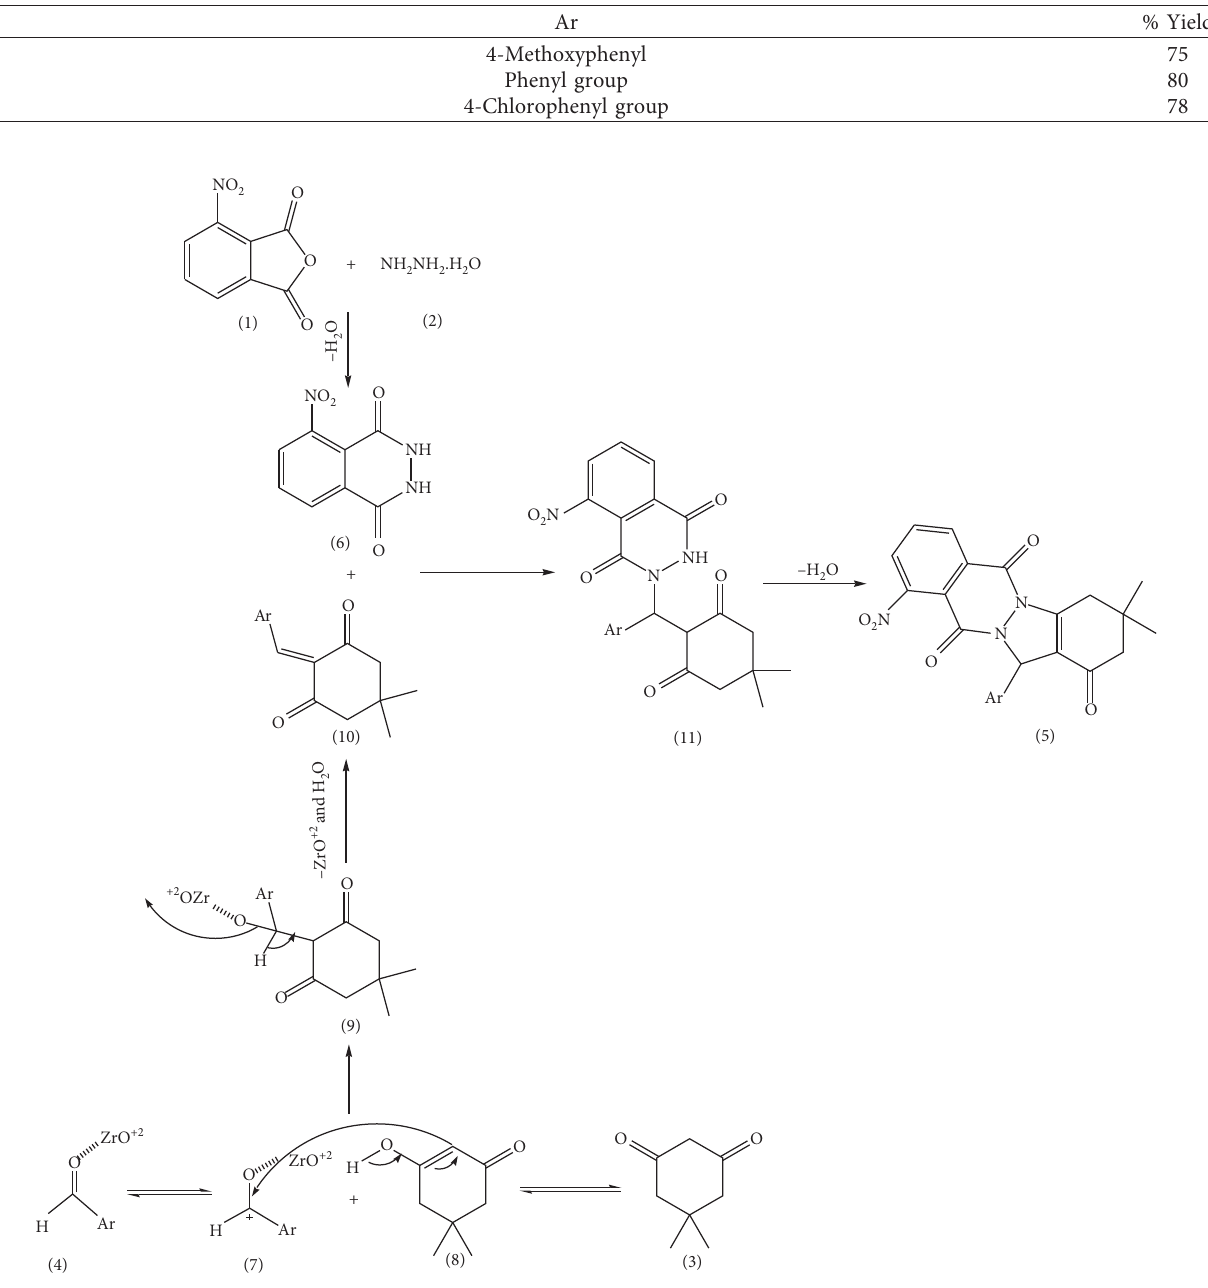
Scheme 1: Three-component reaction of 3-nitrophthalic anhydride, hydrazine monohydrate, dimedone, and aromatic aldehydes (see Table 1). Table 1: Synthesis of 1 H -indazolo[1,2- b ]phthalazine-1,6,11(13 H )-trione derivatives (5a-c)